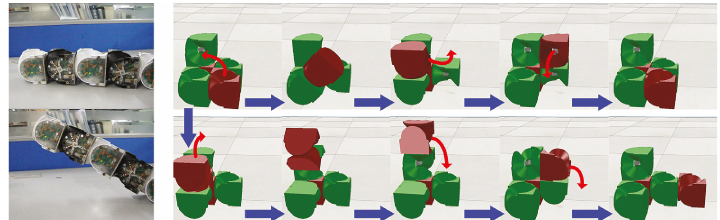
Figure 3: The lifting ability of UBot modules and their relative motion